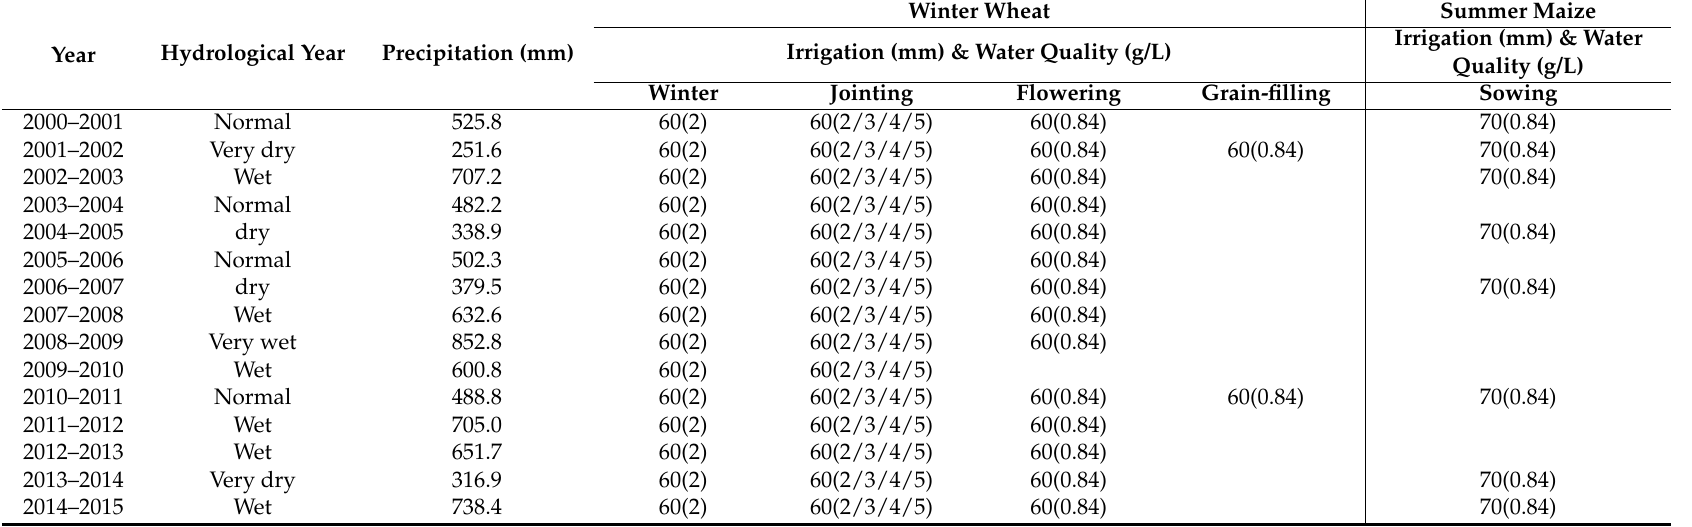
Table 4. Irrigation scenarios designed for different irrigation amounts (mm) and water quality (g/L) (in parentheses) at different growth stages of winter wheat and summer maize in Hebei Low Plains in North